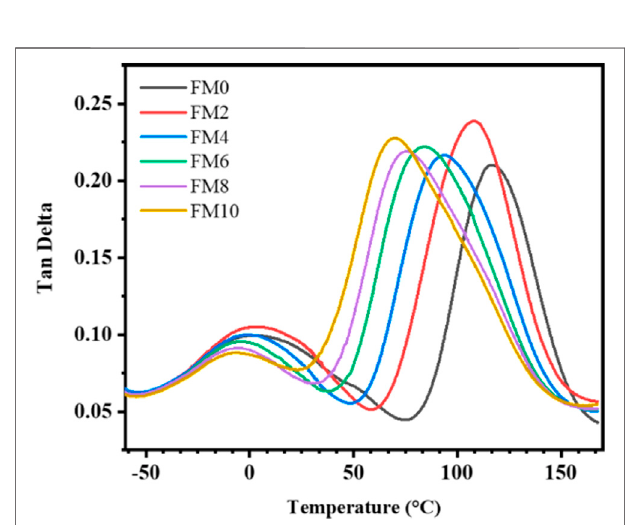
FIGURE 3 | Loss factors of neat PCTFE and PCTFE/FCO blends as a function of temperature.